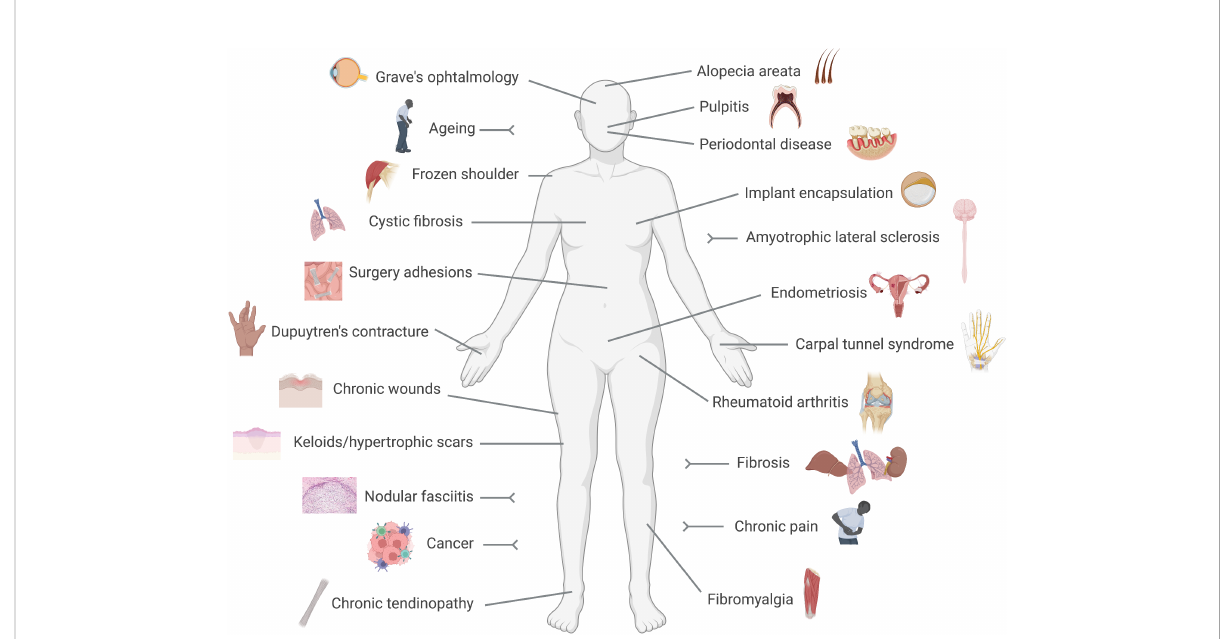
FIGURE 1 Fibroblast-mediated diseases. Conditions in which a pathogenic driving role for fi broblasts has been reported are represented in this cartoon. These include numerous diseases with a clear pro- fi brotic component, like fi brosis, Dupuytren's contracture or implant encapsulation, and conditions in which the immune side of fi broblasts results pathogenic like rheumatoid arthritis or